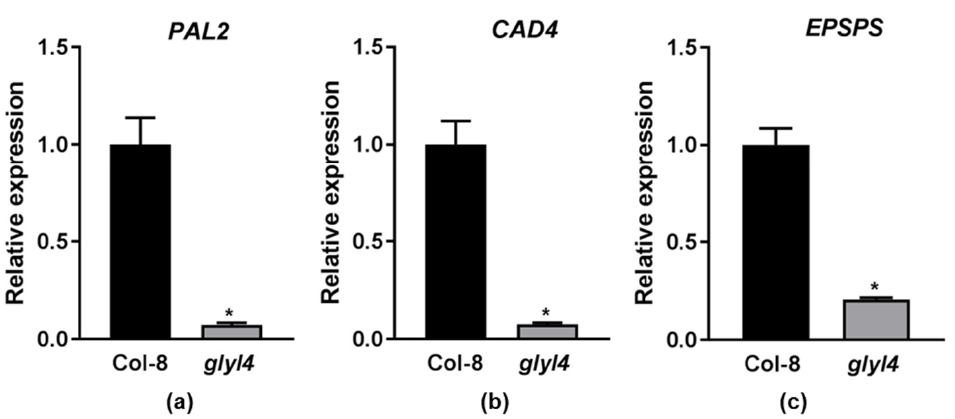
Figure 3. PAL2 ( a ), CAD4 ( b ), and EPSPS ( c ) transcript levels relative to the reference gene UBI10 in Col-8 and the glyI4 mutant. An asterisk indicates a statistically significant difference between genotypes (Mann–Whitney test p -value < 0.05). Error bars represent means ± SDs ( n = 3).